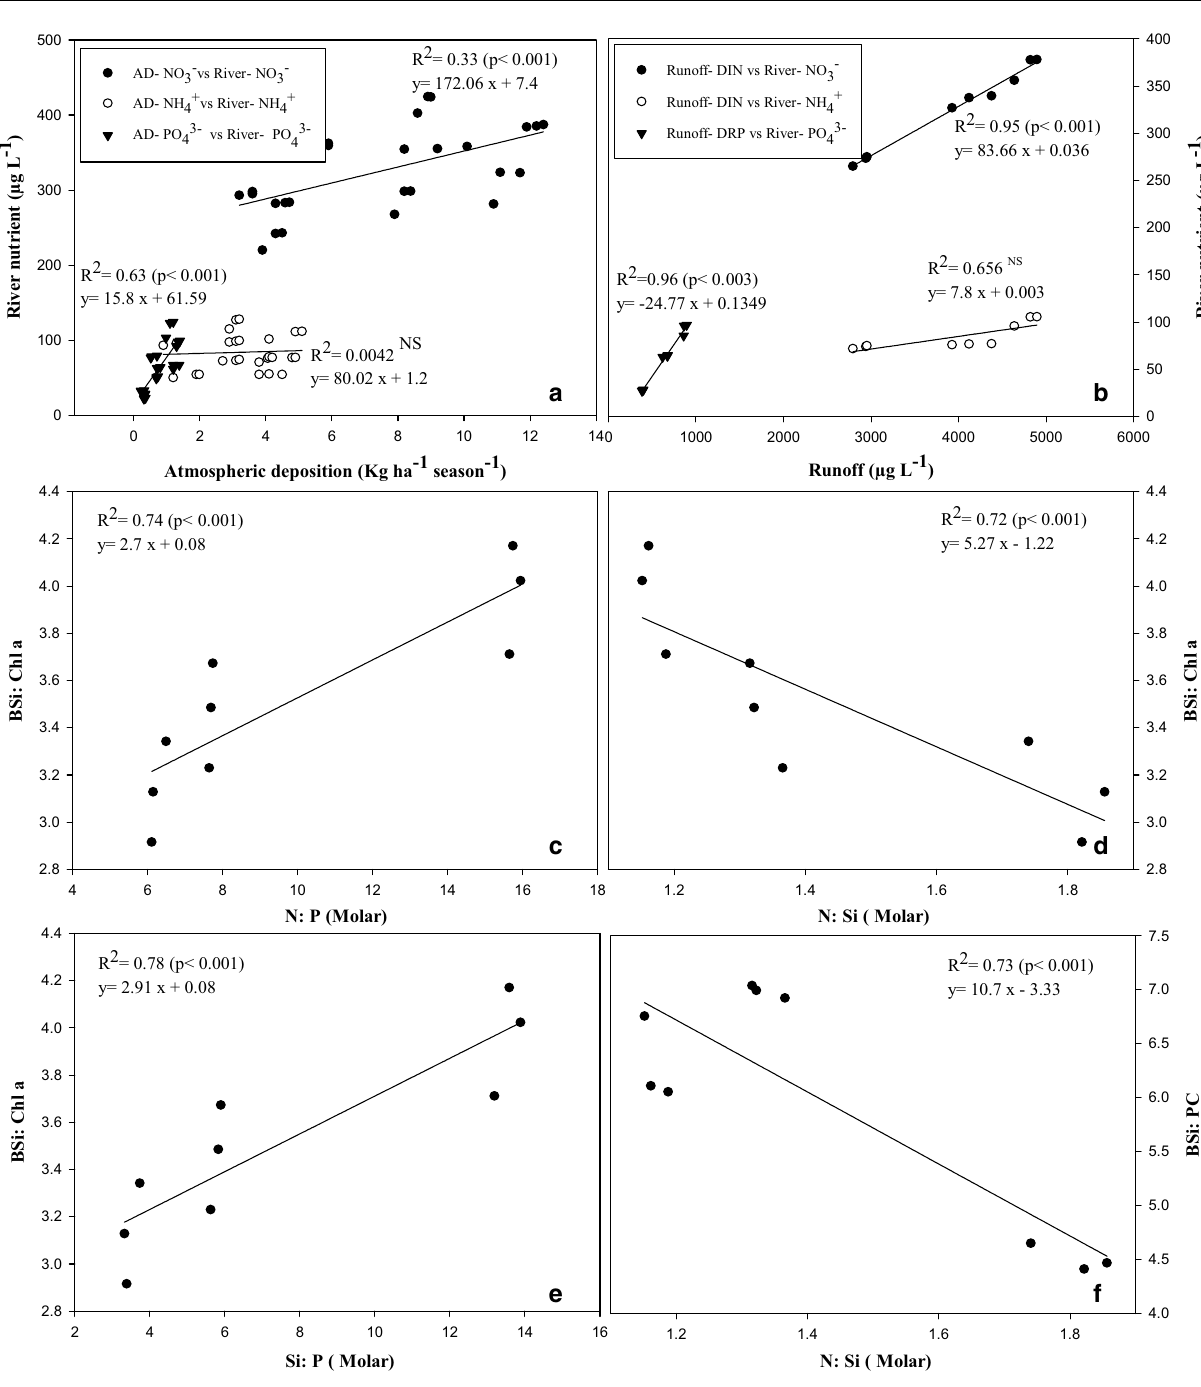
Fig. 8 Correlation between a atmospheric N, P and river N, P; b runoff N, P and river N, P; c river N/P ratio and BSi/Chl a ; d river N/Si ratio and BSi/Chl a ; e river Si/P ratio and BSi/Chl a ; and f river N/Si ratio and